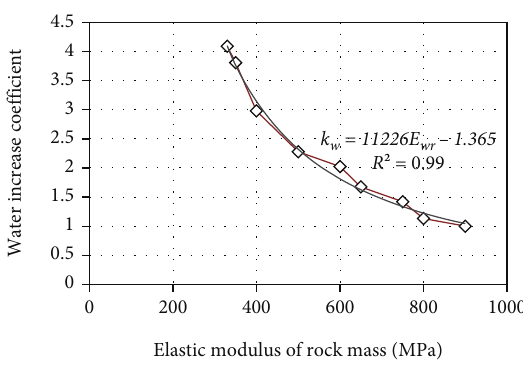
Figure 15: The graph of dependence of water increase coe ffi cient ( k w ) on elastic modulus ( E ) of rocks in a wet rock